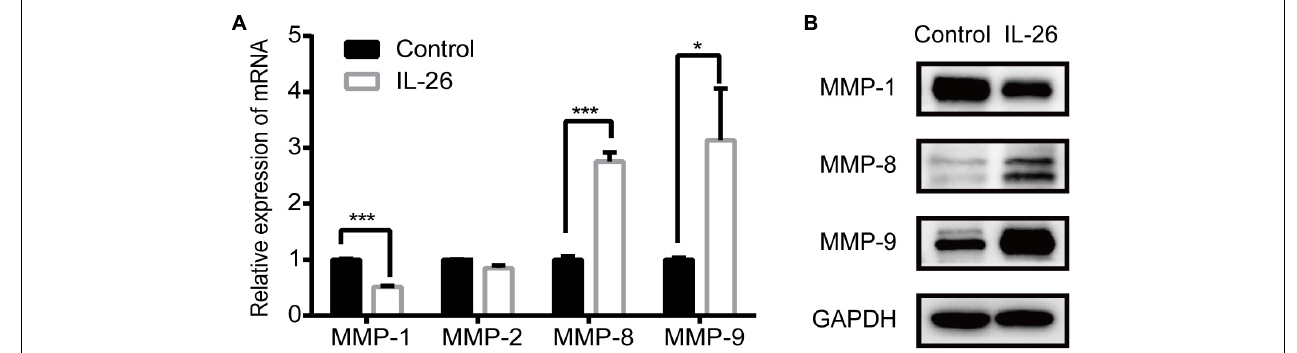
FIGURE 6 | Effect of IL-26 on matrix metalloproteinases (MMPs) expression in THP-1 macrophages. (A) mRNA levels of MMP-1, MMP-2, MMP-8 and MMP-9 in THP-1 macrophages treated with IL-26. Results are expressed as mean ± SD and are representative of three independent biological replicates. (B) Protein expression of MMP-1, MMP-8 and MMP-9 in THP-1 macrophages treated with IL-26. Images are representative of two independent biological replicates. * P < 0.05, *** P <